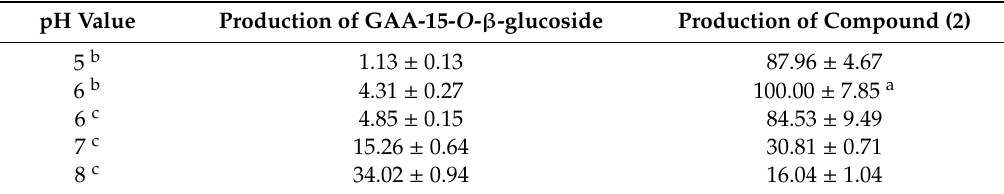
Table 1. Relative production a of GAA-15- O - β -glucoside and compound ( 2 ) catalyzed from GAA by BsGT110.